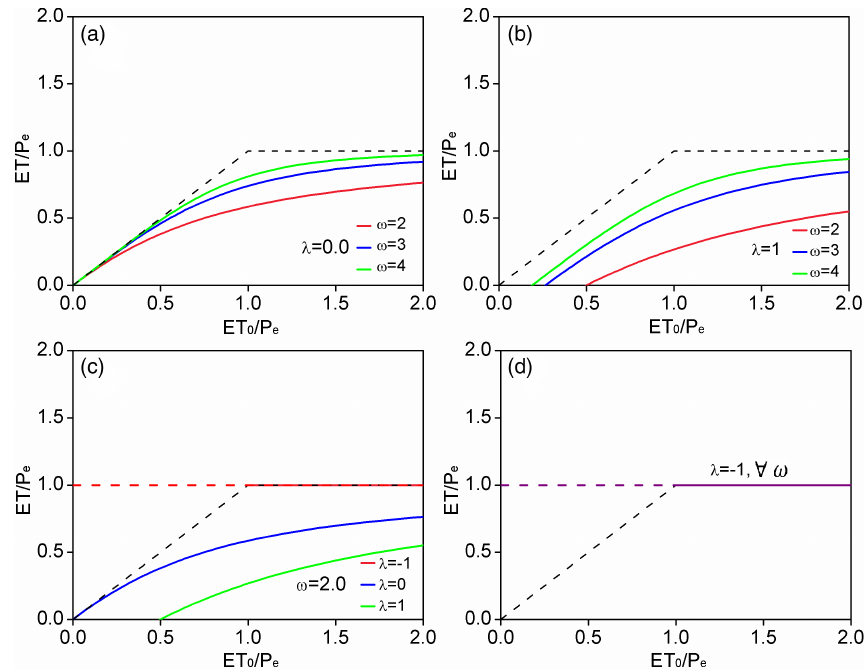
Figure 2. The Budyko curves in Eq. (8) with different combinations of parameters ω and λ